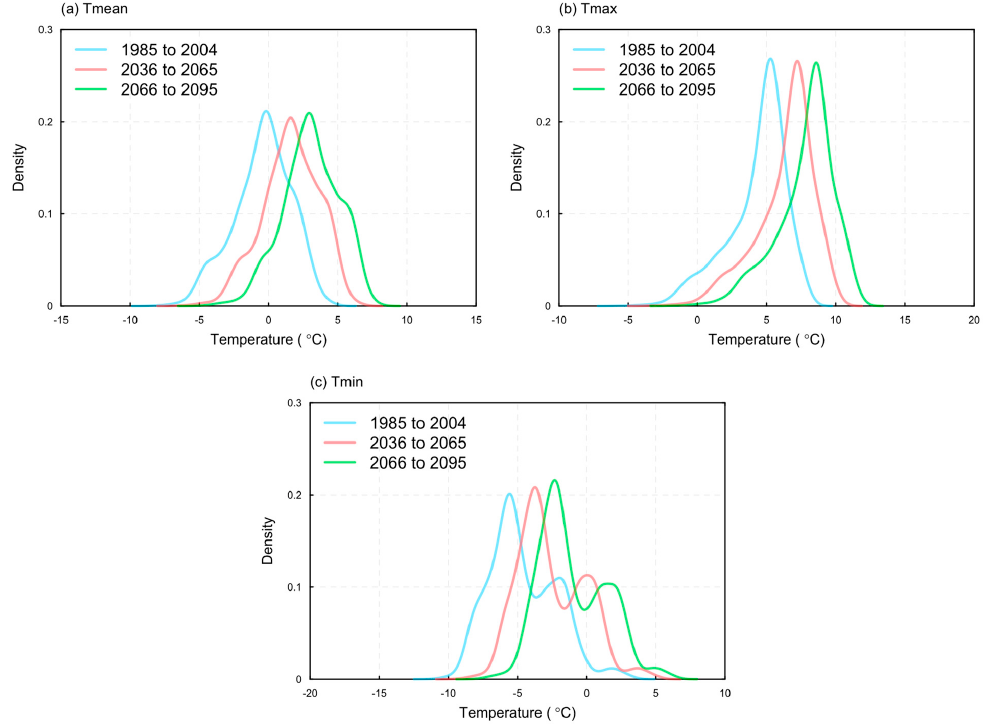
Figure 8. Spatial distribution of annual averages for the historical and future periods under RCP85. ( a ) T mean , ( b ) T max , and ( c ) T min .